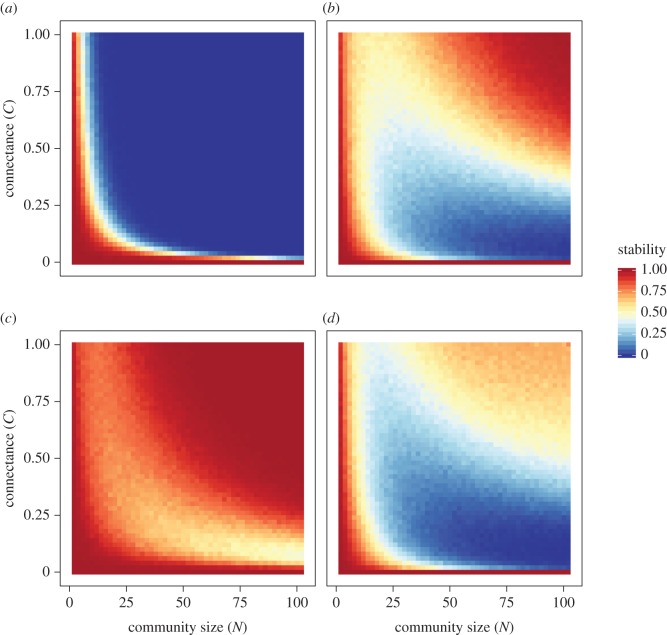
The complexity–stability relationship in random communities with or without density-dependence variation. Different colours indicate the proportions of stable communities among 1000 samples. The distributions of density dependence used were (a) βij = δij = U(−0.2, 0.2) (i.e. the condition comparable to the May's stability criterion), (b) βij = U(−1.0, 0.0) and δij = U(−0.3, 0.1), (c) βij = U(−0.4, 0.0) and δij = U(0.0, 0.4), and (d) βij = U(−0.1, 0.3) and δij = U(0.0, 1.0). Other parameters: smax = 2.0, Xmax = 2.0, bmax = 1.0 and dmax = 1.0.